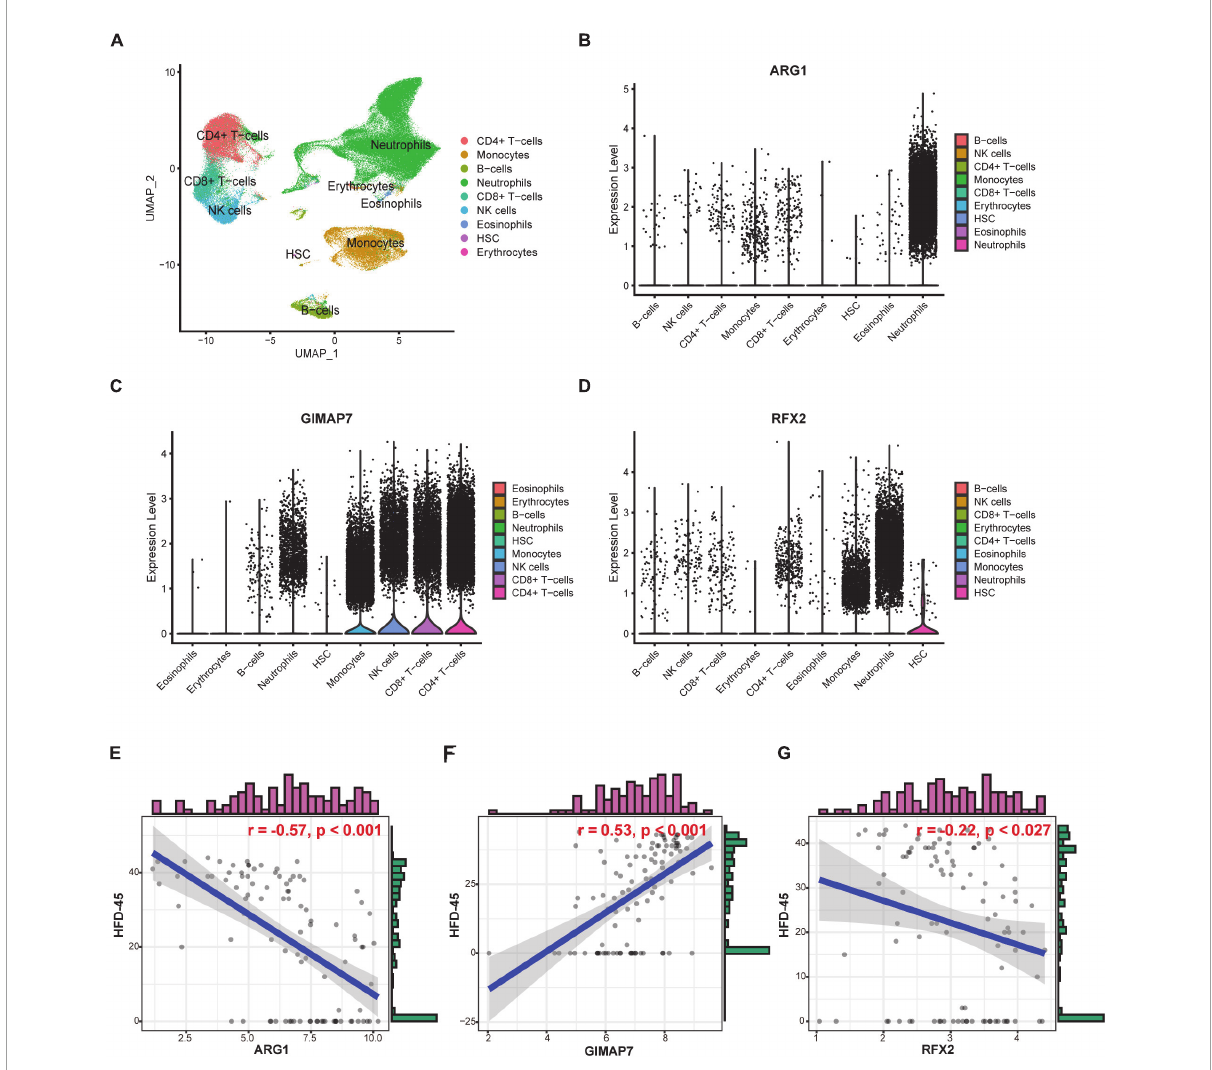
FIGURE9 Cell-specific expression and prognostic predictive power of severity-associated genes. (A) UMAP plot shows 122,954 cells isolated from control and COVID-19 patients, colored by the main cell groups. (B–D) Violin plot of ARG1, GIMAP7, and RFX2 expression in different cell groups. The level of expression increases from left to right. (E–G) Correlation analysis of ARG1, GIMAP7, RFX2 expression levels and